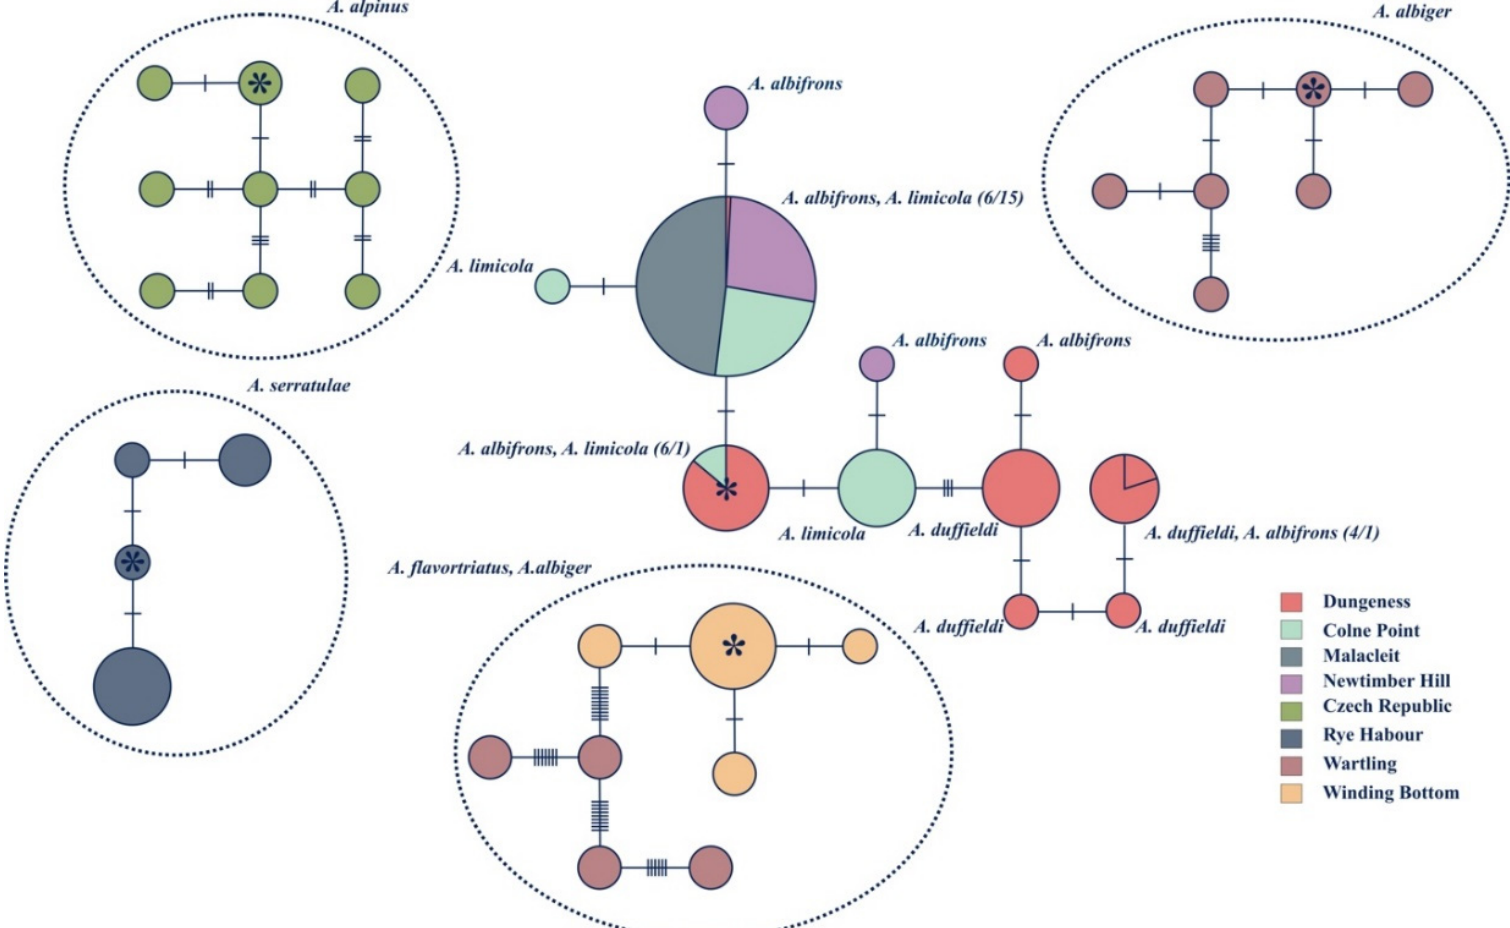
Figure 5. TCS network based on the mitochondrial CO1 gene. Each circle represents a unique haplotype, and the size of each circle is proportional to the number of samples. Cross-hatching along branches represents the number of mutational steps. (TCS only connects alleles with a 95% confidence limit, i.e., 10 steps). The colours represent localities, and the circles are labelled with the name of the haplotype as seen in Figures 2–4. Stars indicate ancestral haplotypes.